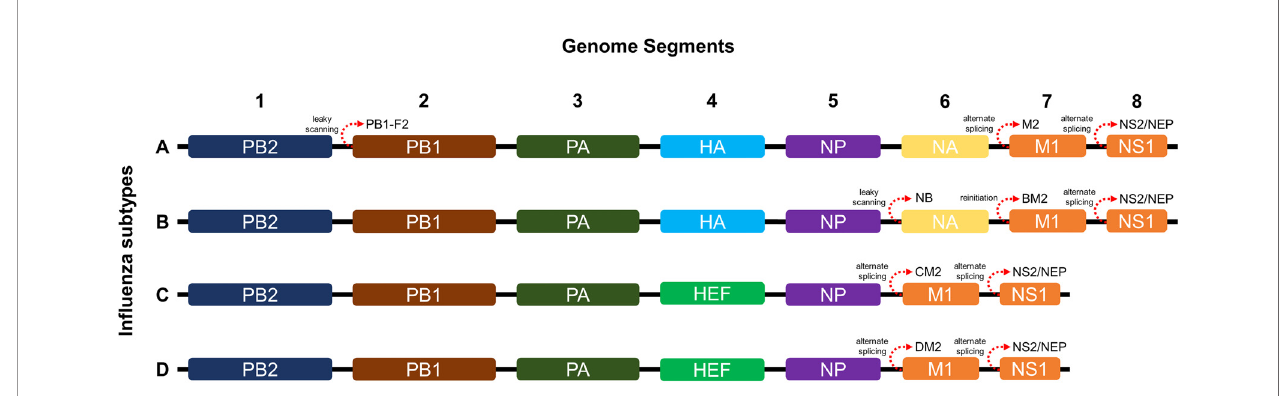
FIGURE 1 | Genome segments and gene arrangements of in fl uenza virus subtypes. The A and B subtypes contain eight segments, while the C and D subtypes contain only